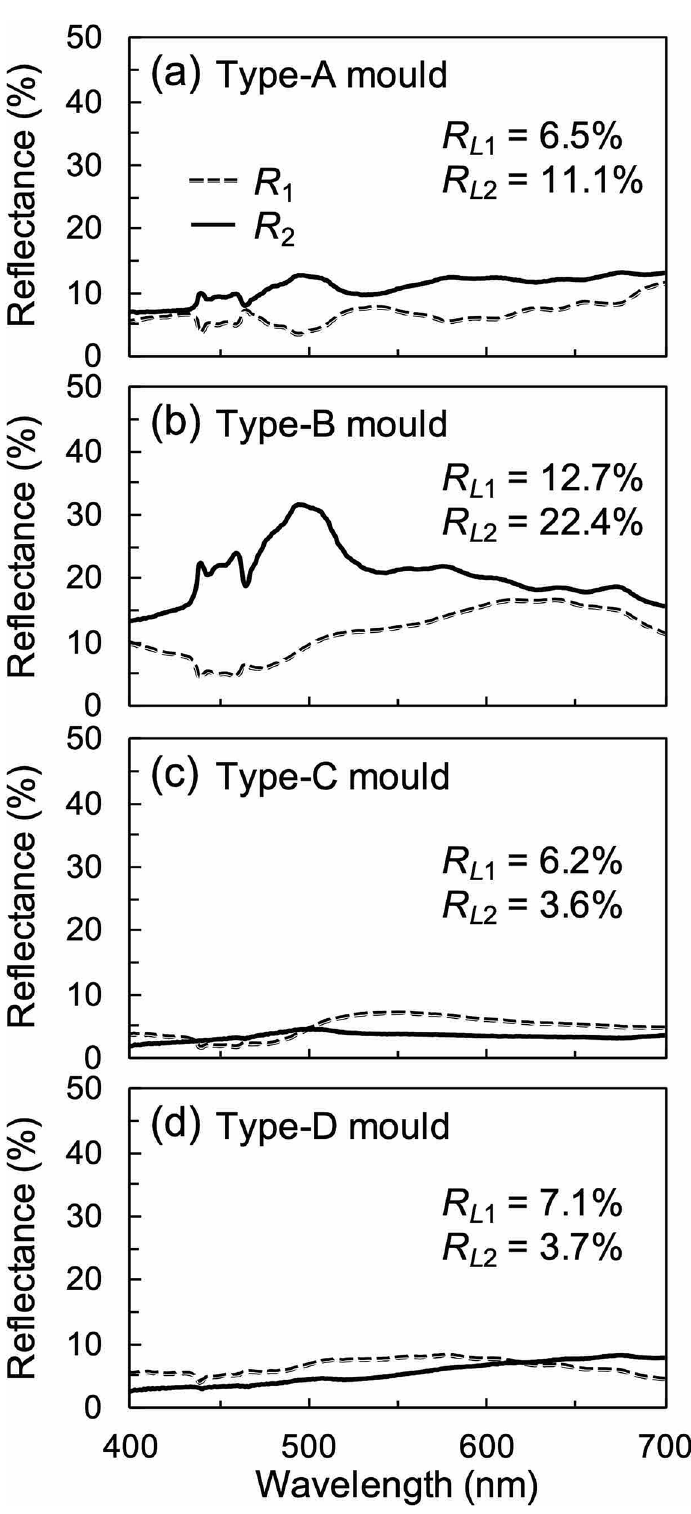
Figure 8. Measured reflectance spectra of WGP sheets printed by using ( a ) type-A, ( b ) type-B, c type-C and d type-D moulds. The incident light is